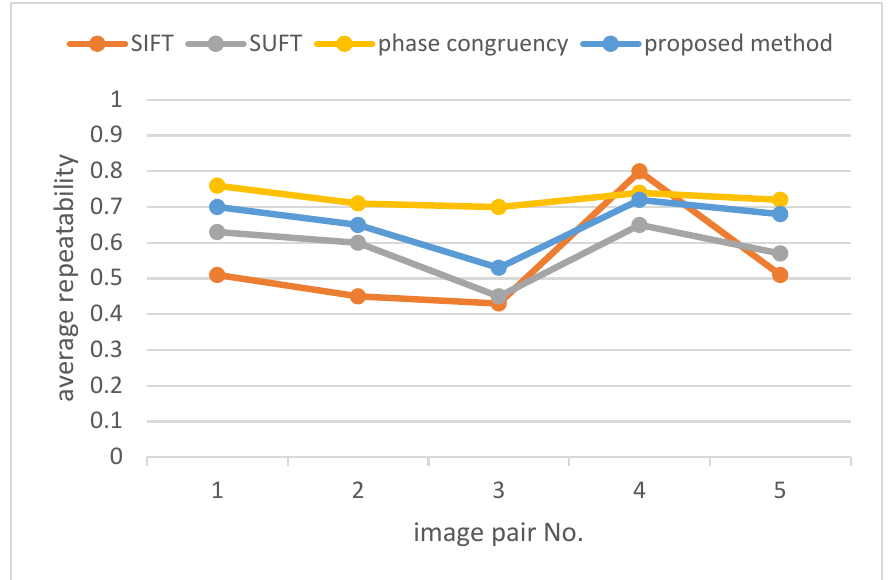
Figure 8. Average repeatability of several feature point extraction methods.